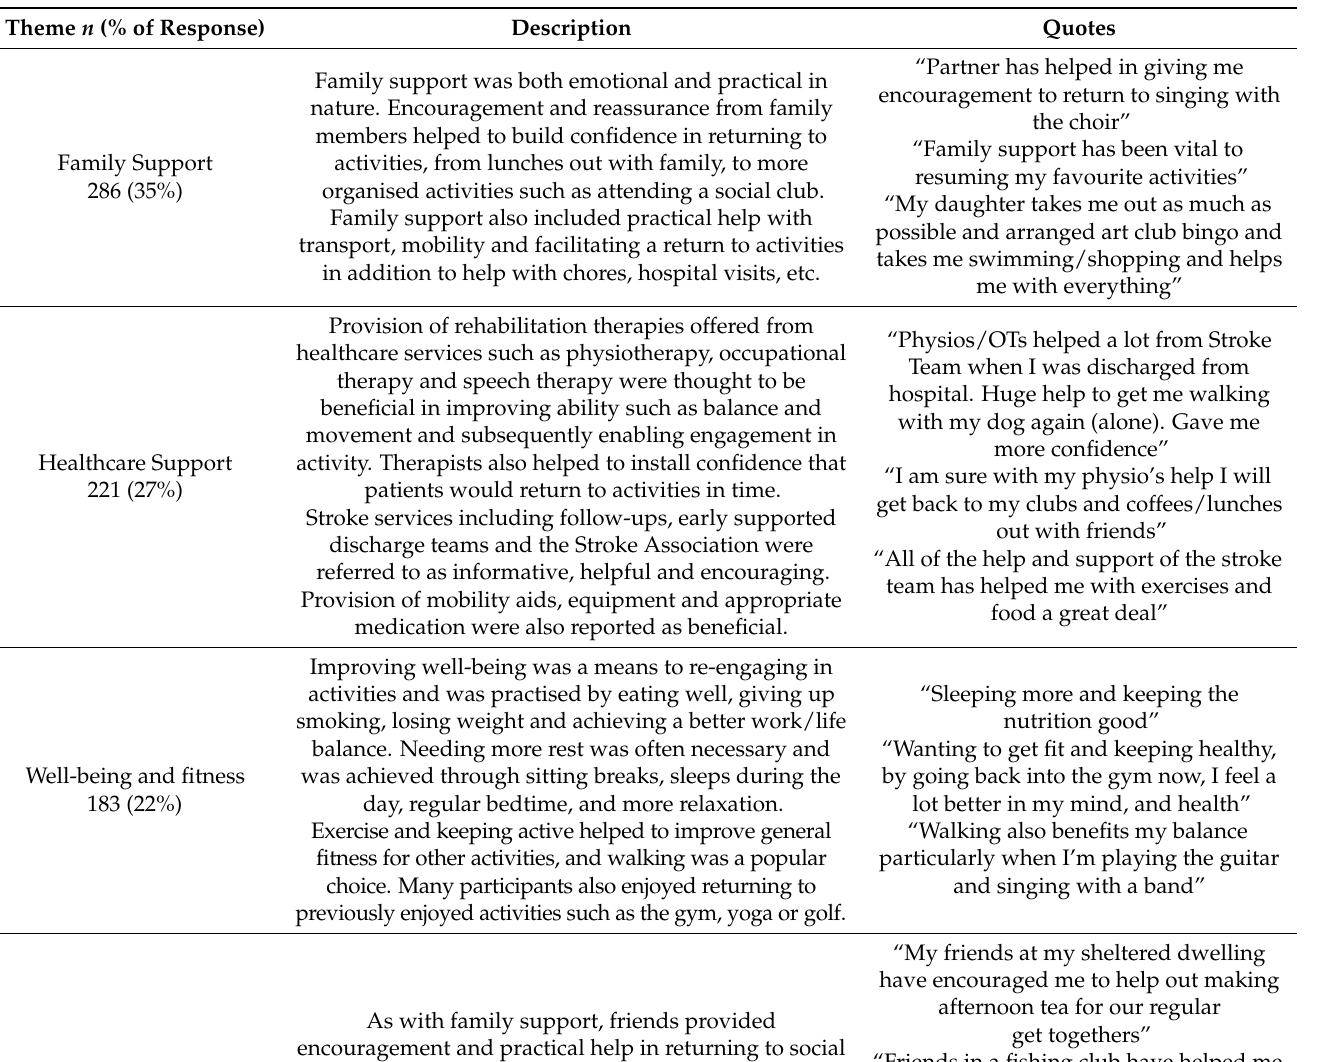
Table 3. Conceptual themes identified for facilitators to activity at 6 month follow-up, number of participants in each theme and proportion of response